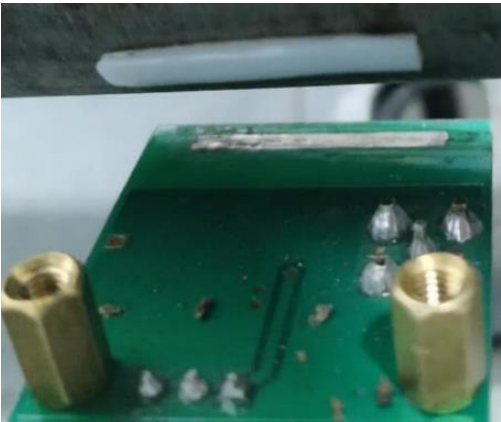
Figure 15. Photograph of the sensor and strip.